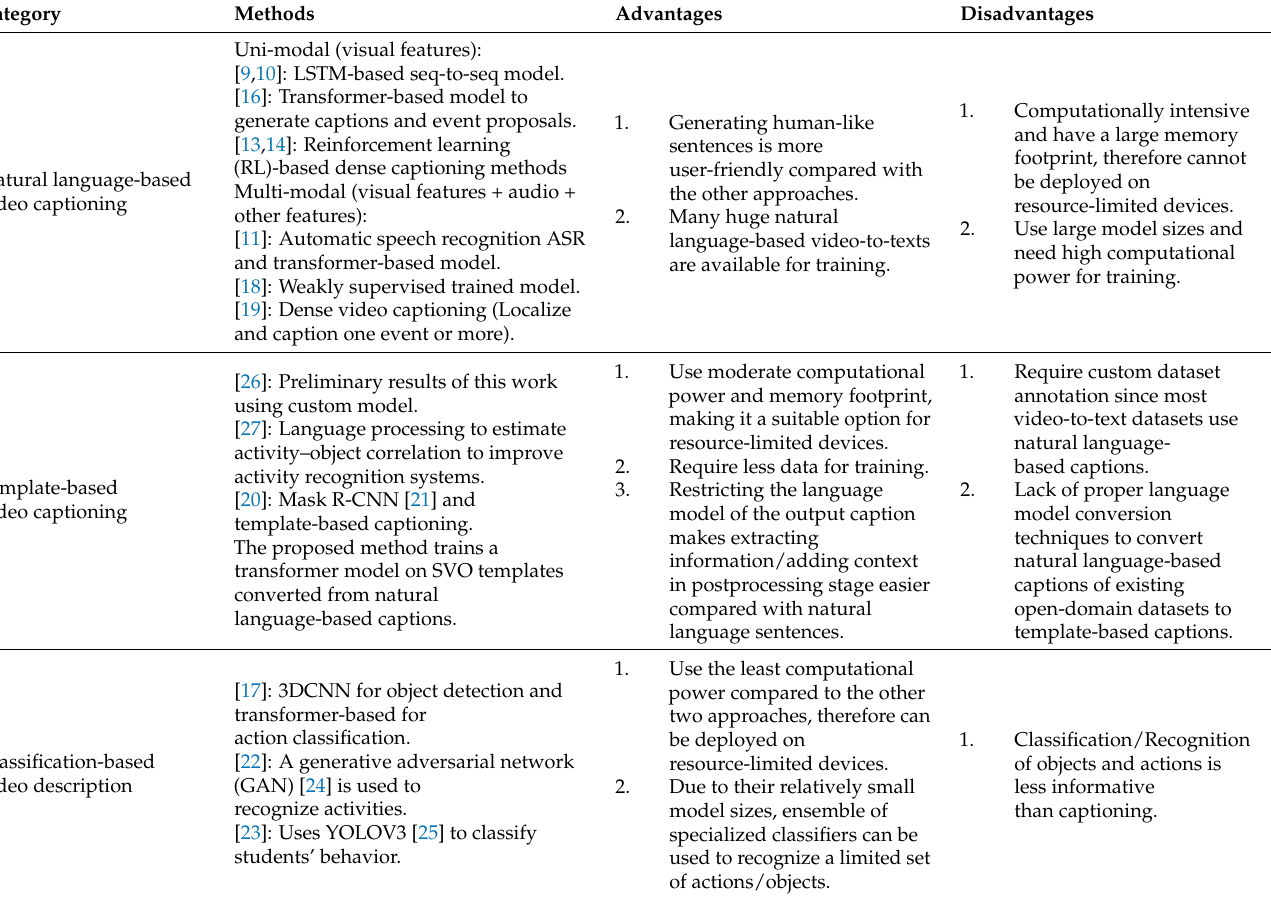
Table 1. Summary of related